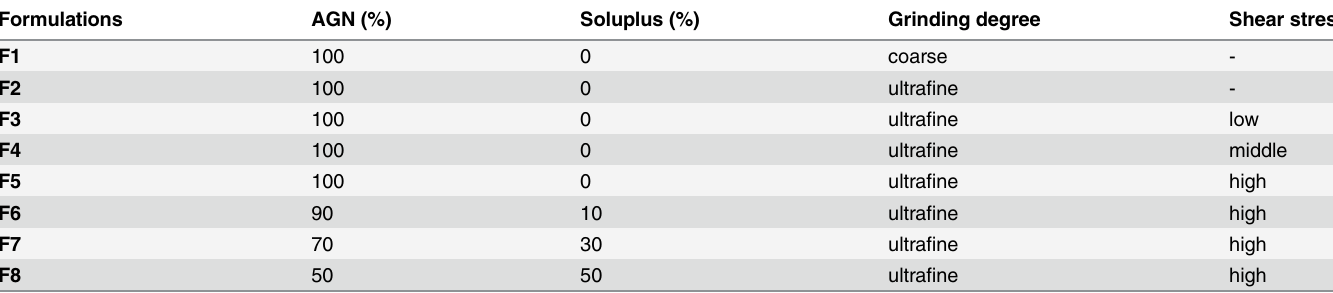
Table 1. The compositions and processing conditions of developed formulations.